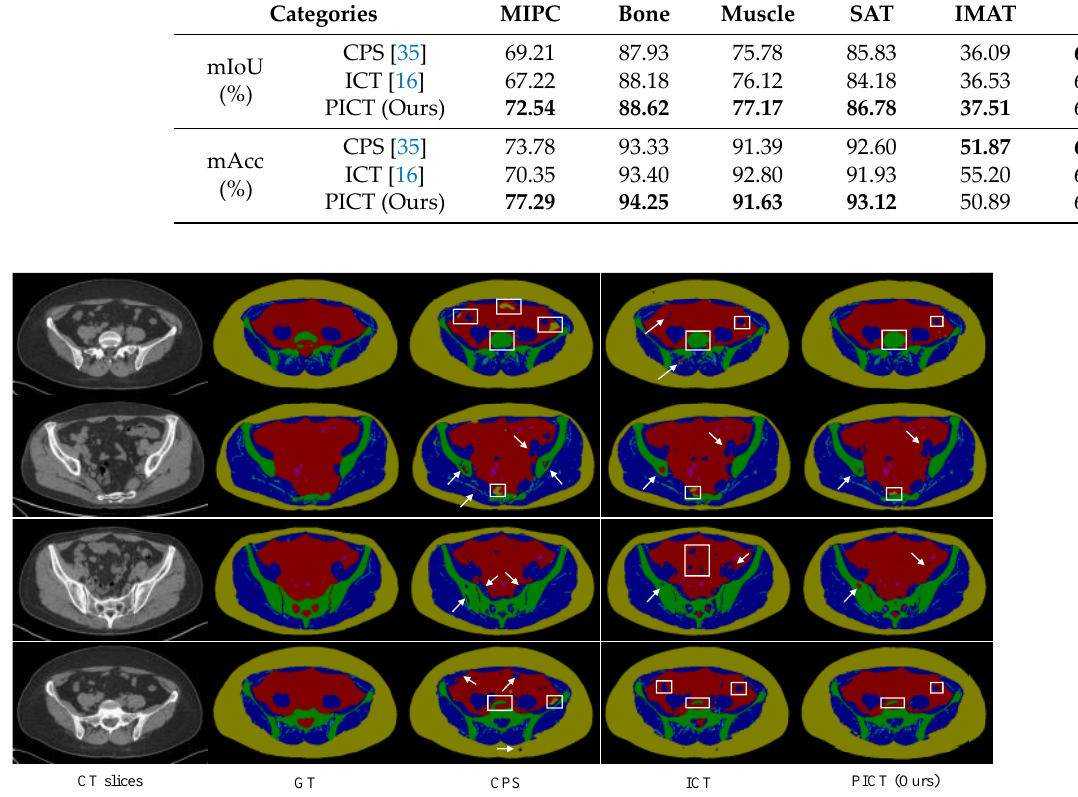
Figure 10. Visual comparison of the state‑of‑the‑art methods on Multi‑tissues Pelvic test images. The